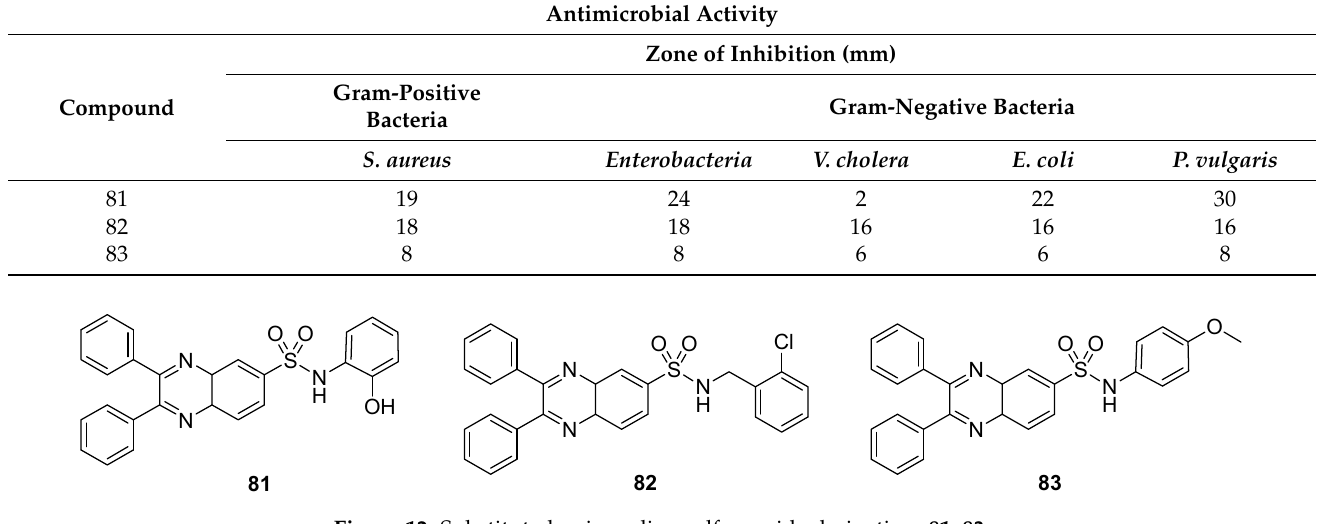
Figure 12. Substituted quinaxoline sulfonamide derivatives 81–83 . Table 6. Antimicrobial activity of quinoxaline derivatives 81–83 .